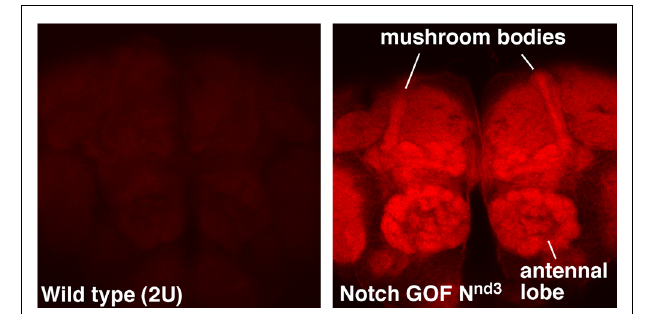
FIGURE 1 | F-actin is enriched in specific regions of the fly brain immediately after Notch activation. Mushroom bodies and antennal lobes where Notch is known to function are labeled. N nd3 is the same temperature-sensitive Notch GOF allele used in Zhang etal. (2013).The wildtype (2U) and N nd3 flies were incubated at 30 ◦ C for 30 min to activate Notch and the brains were dissected and fixed immediately (see Zhang etal., 2013 for details). Dissected brains were processed identically and F-actin detected using Alexa